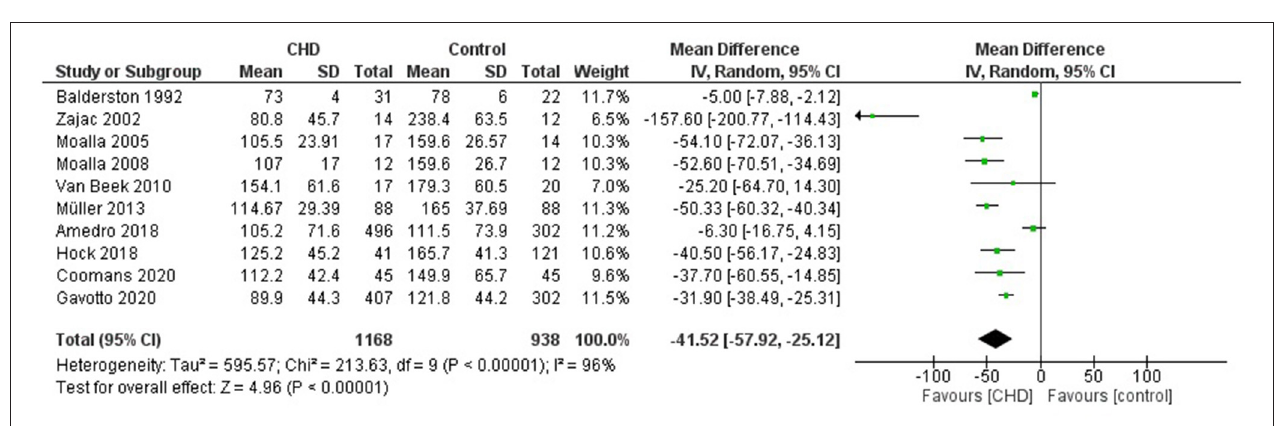
FIGURE 4 | Forest plot for mean maximum workload for CHD in children and adolescents and healthy controls.